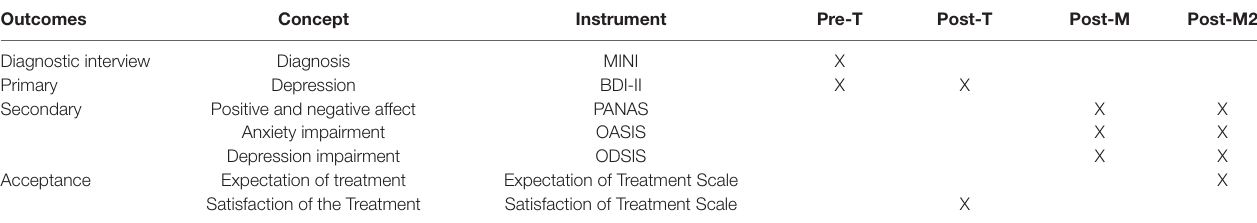
TABLE 2 | Study measures, assessment area, and time of